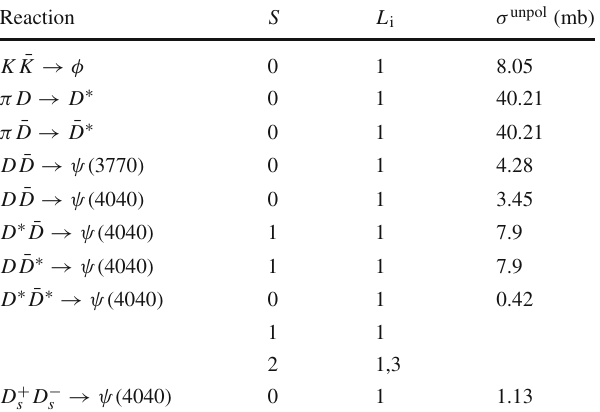
Table 7 Total spin, orbital-angular-momentum quantum number, and cross section